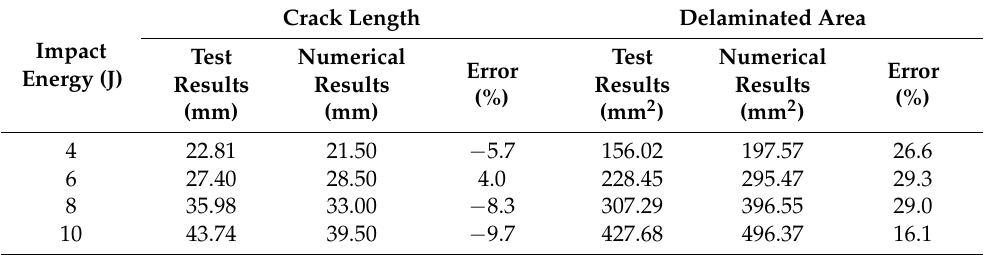
Table 5. Comparison of the damage size.